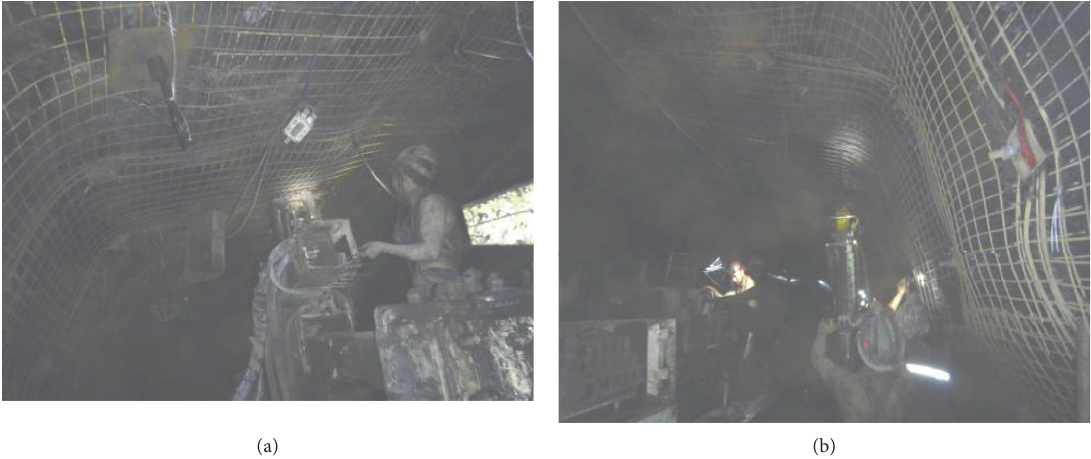
Figure 18: Site anchor bolt construction. (a) Hydraulic bolting rig in action. (b) Hand-held pneumatic bolt drill in action.